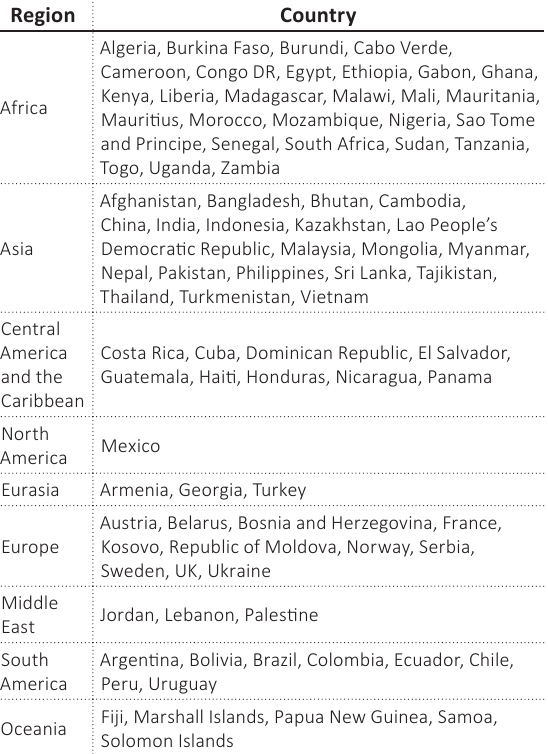
Table 1. Objects of research Source: Own processing (International Renewable Energy Agency,